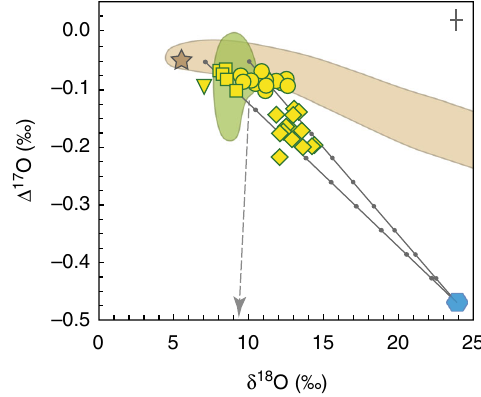
Fig. 1 Oxygen isotope systematics in tektites and impact glasses from this study. Mixing lines between siliciclastic and ma fi c materials ( δ 18 O = 10.0 ‰ and 7.0 ‰ , respectively) and air O 2 are indicated, bullets represent 10% increments. Circles — moldavites; diamonds — irghizites; squares — basic splash forms; reversed triangle — composite splash-form; brown fi eld — the range of common crustal rocks 54 with revised data for San Carlos olivine 76 ; green fi eld — the recalculated oxygen isotope compositions of other tektites 20 (Australasian tektites, North American tektites). The oxygen isotope compositions of the Earth ’ s mantle (star) 76 and air (hexagon) 22 are plotted. Carbonaceous chondrite groups other than CI have more negative Δ 17 O values ( dashed arrow ). The maximum 2 s.d. error bars for δ 18 O and Δ 17 O are plotted NATURE COMMUNICATIONS | 8: 227 | DOI: 10.1038/s41467-017-00192-5 |